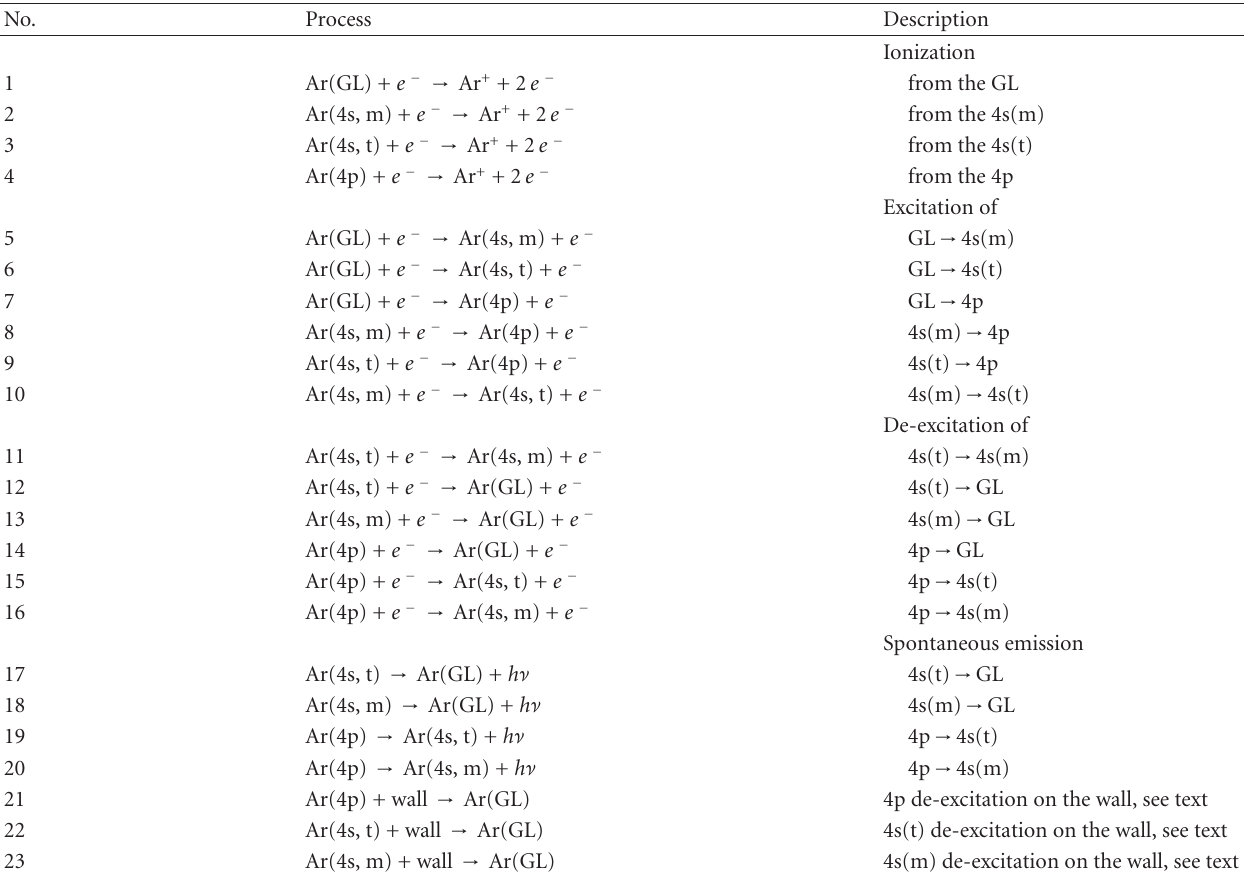
Table 2: Inelastic processes involving Ar I 4s and 4p